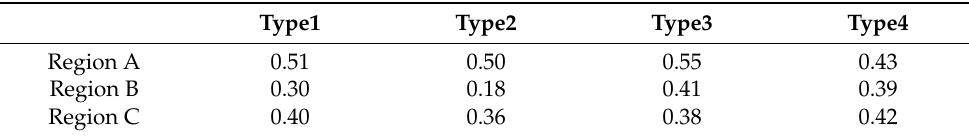
Figure 5. Hourly change during the daytime (per day from 0900 to 1600 LST; LST is UTC + 8) of the mean chl-a concentration in the three regions shown in the black box in Figure 3d, ( a ) Region A; ( b ) Region B; ( c ) Region C. Table 1. Diurnal amplitude of the regional chl-a concentration (mg m −3 ) under the four synoptic types.